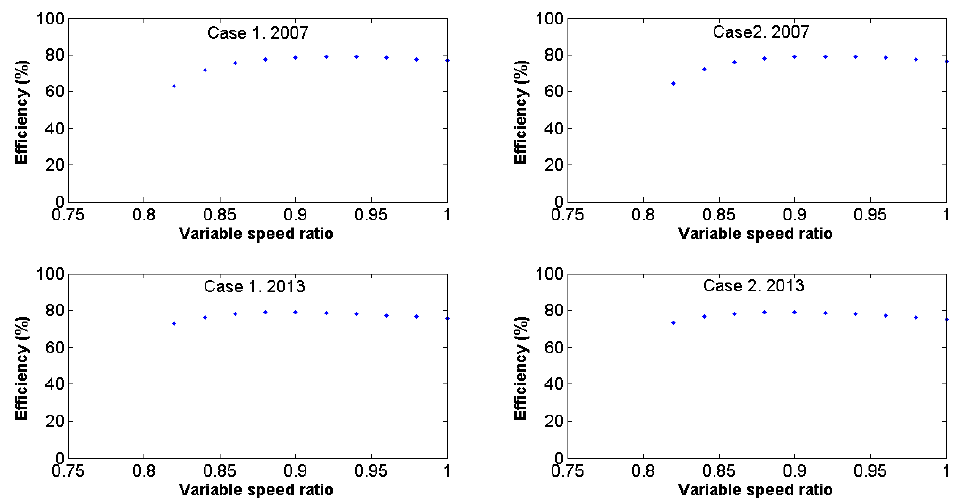
Figure 14. Pump efficiency (%) depending on the variable speed ratio in WUA C.